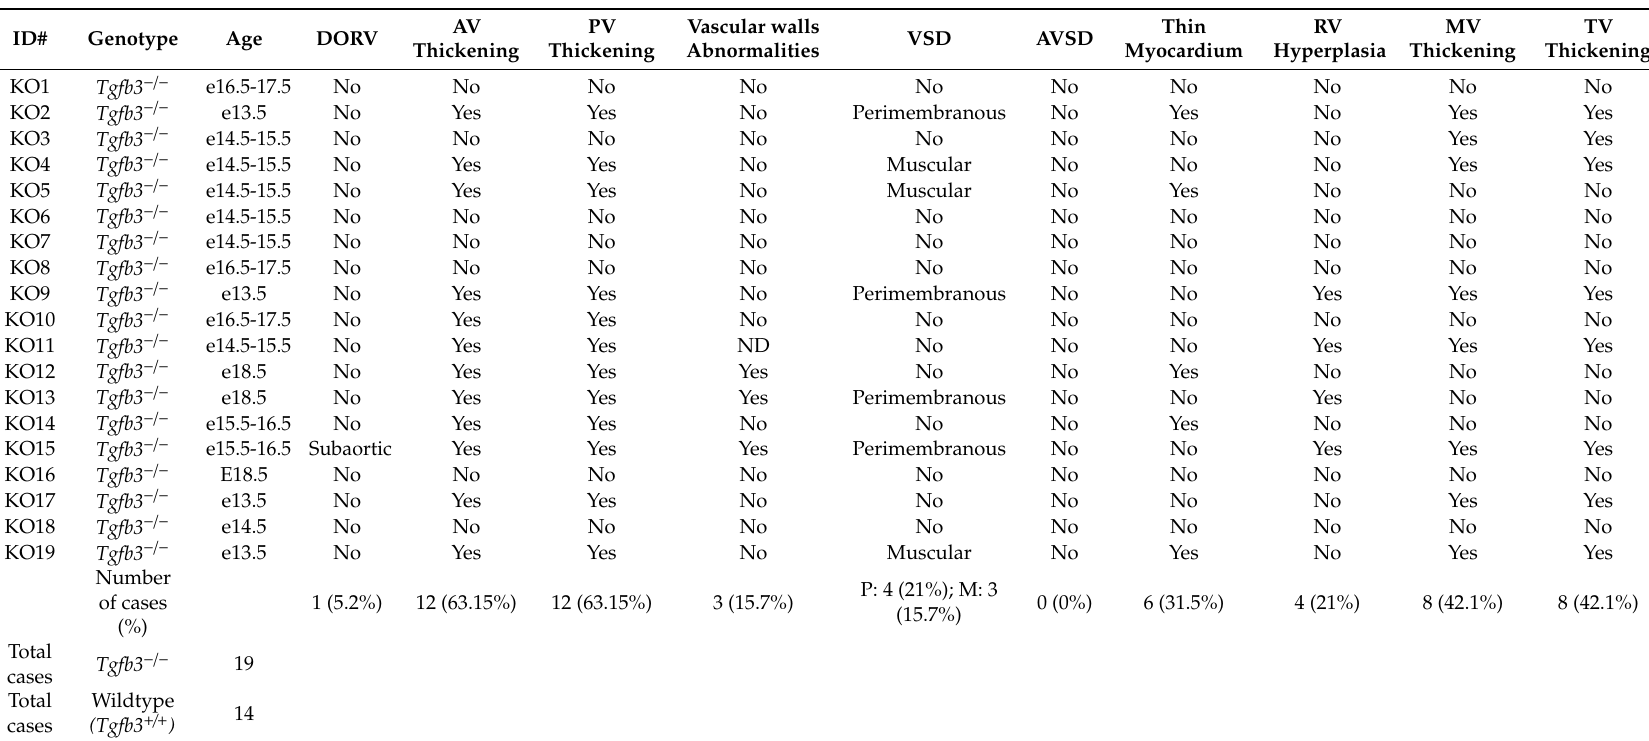
Table 1. Summary of cases with or without cardiovascular defects in Tgfb3 knockout mice (Embryonic Day 13.5 to 18.5; n =